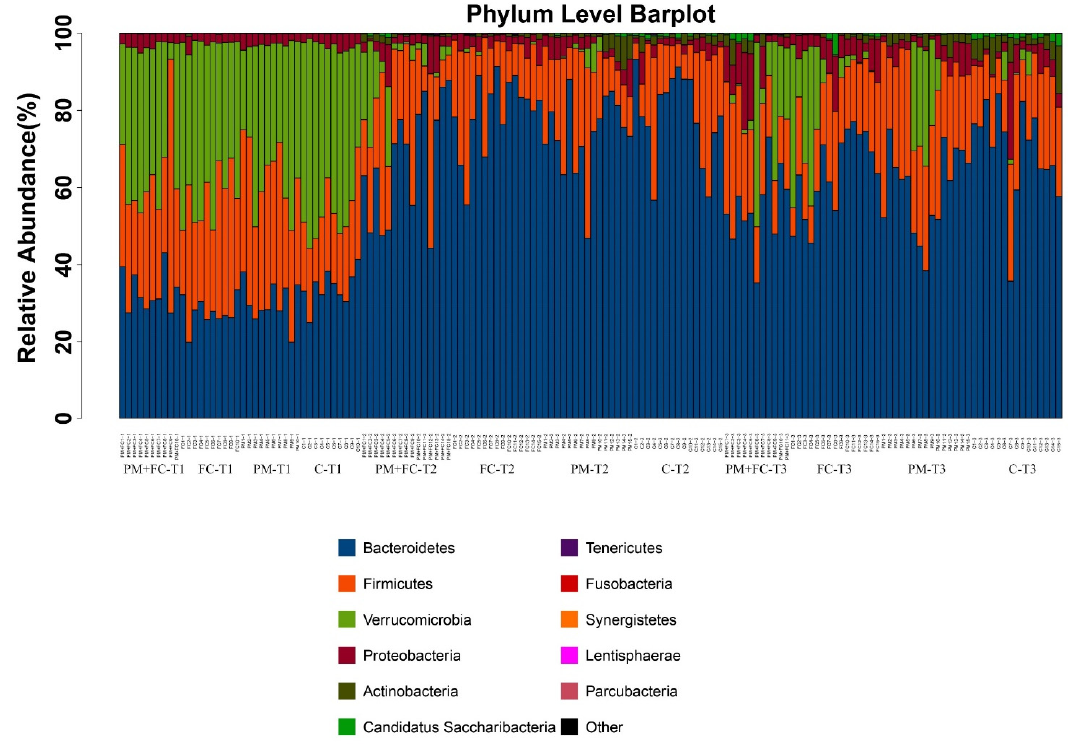
Figure 8. Phylum level barplots of mouse fecal microbiota of four groups (group PM, group PM + FC, group FC, and group C).